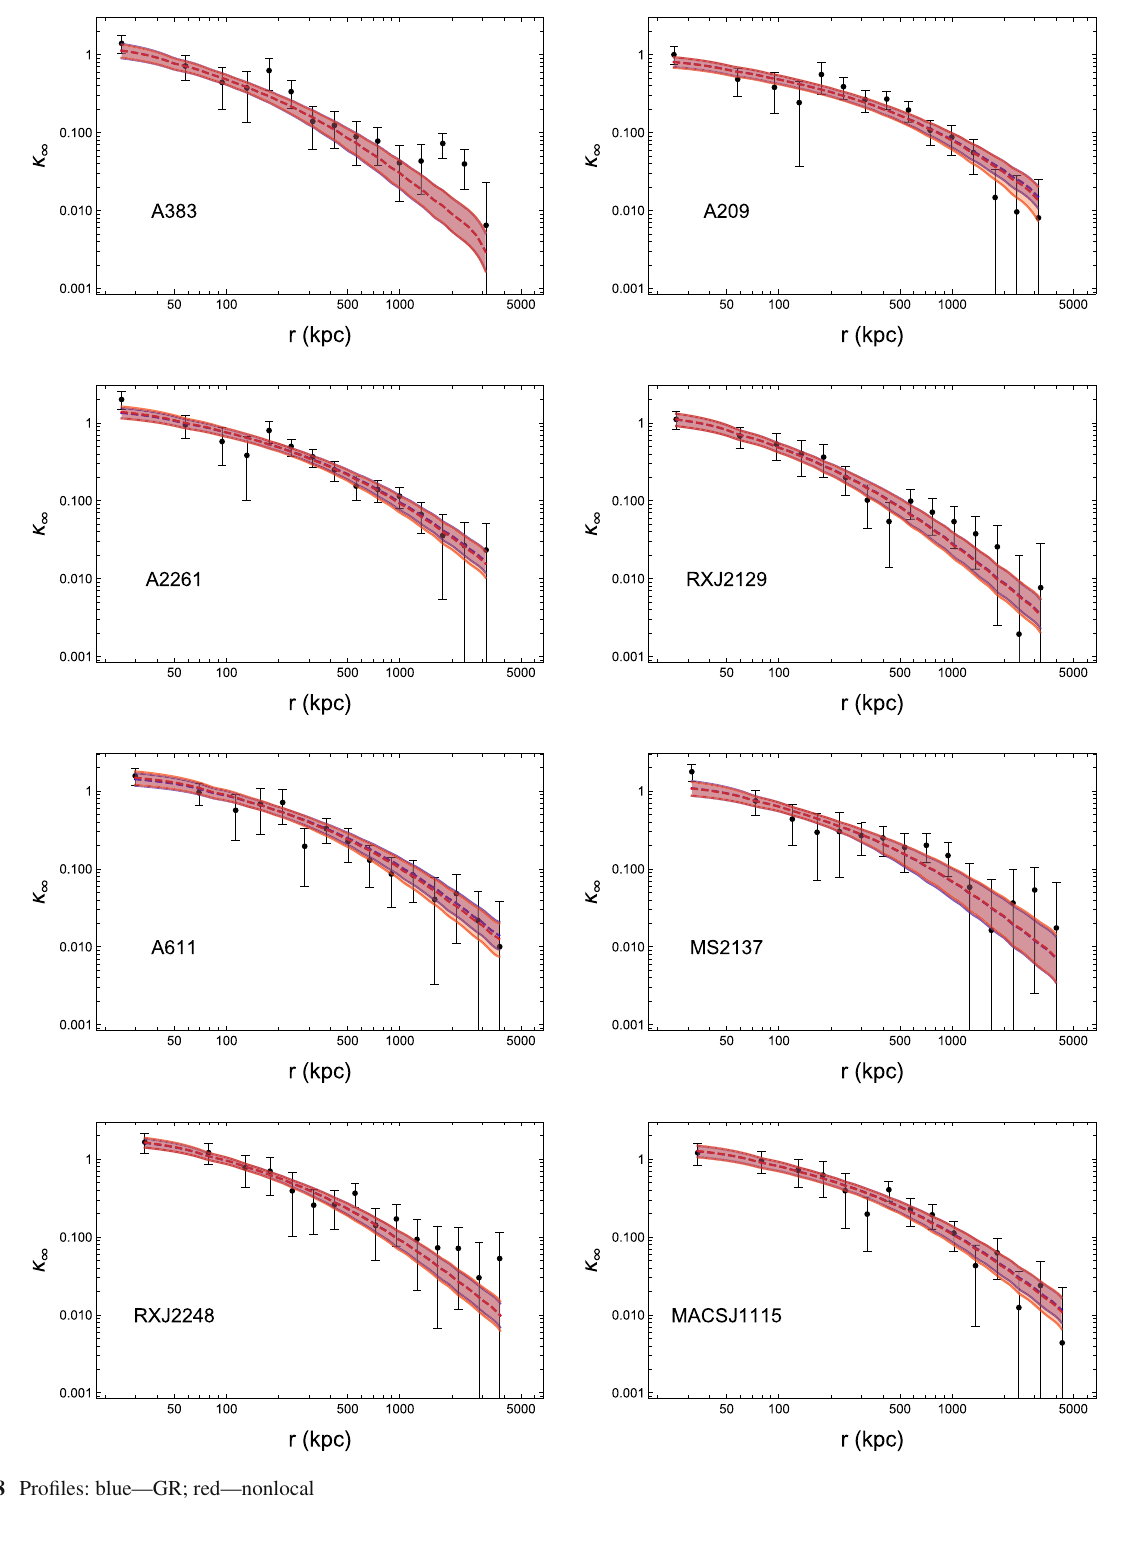
Fig. 8 Profiles: blue—GR;